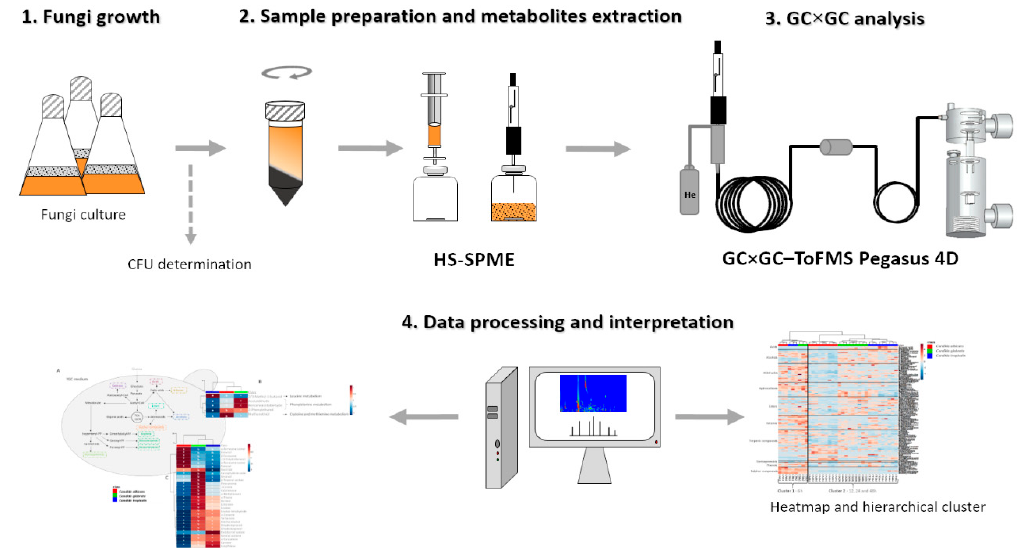
Figure 2. Workflow representation of the main stages for Candida species exometabolome analysis.